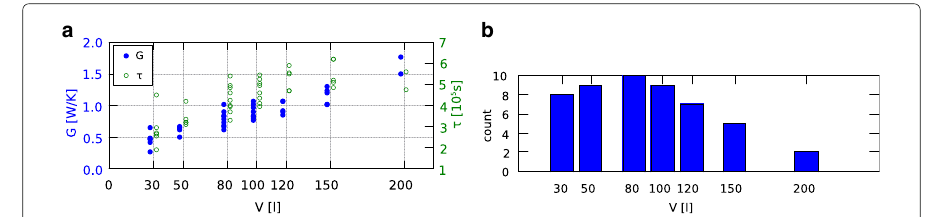
Fig. 3 Considered DEWH parameter base from selected manufacturers. a Volume / heat conductivity of DEWH, b Assumed discrete normal distribution of volumes N (μ = 70, σ 2 = 70 2